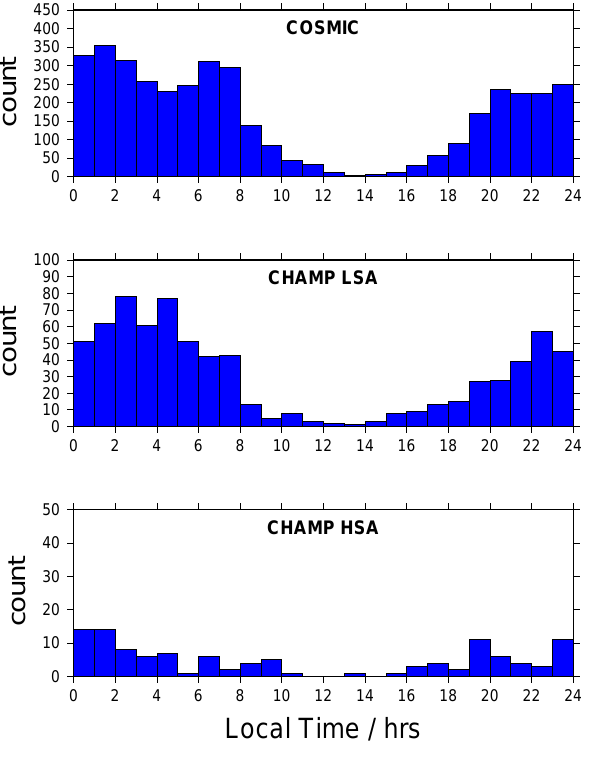
Fig. 2. Local time dependence of Formosat-3/COSMIC profiles which statisfy the ELDI condition. Top: Formosat-3/COSMIC pro- files, middle: CHAMP profiles from the period 2005/06 with low solar activity (LSA) and bottom: CHAMP profiles from 2002/03 at high solar activity (HSA).